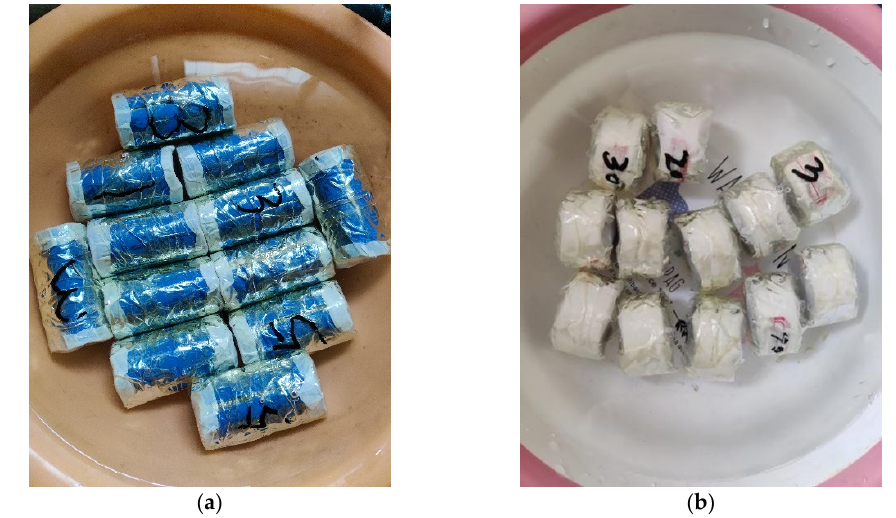
Figure 2. Pictures of the test samples ( a ) Samples for triaxial shear test, ( b ) Samples for microstructural analysis.